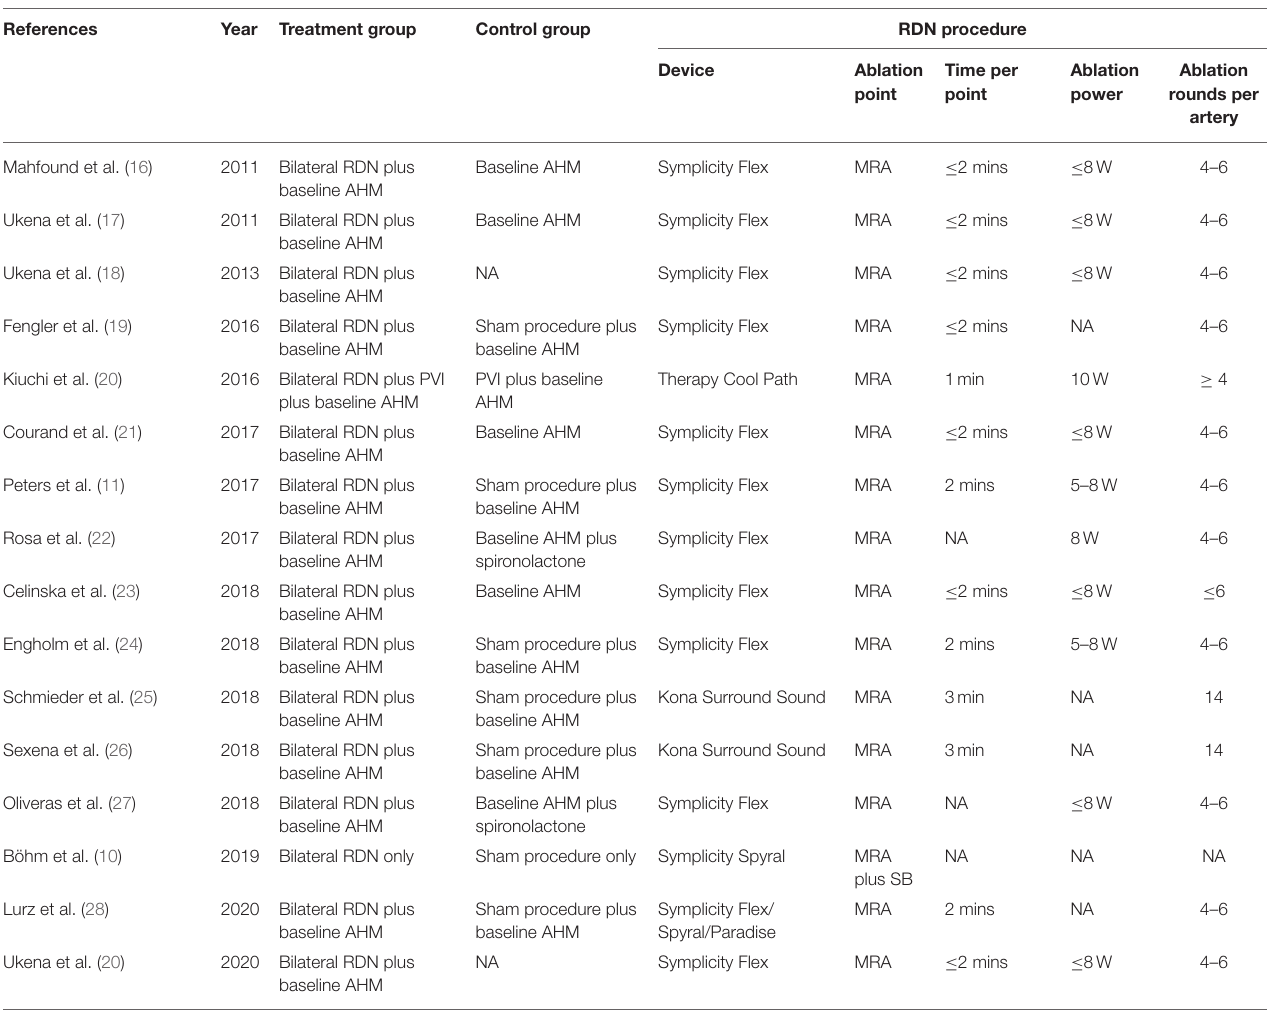
TABLE 2 | Comparisons of intervention between included